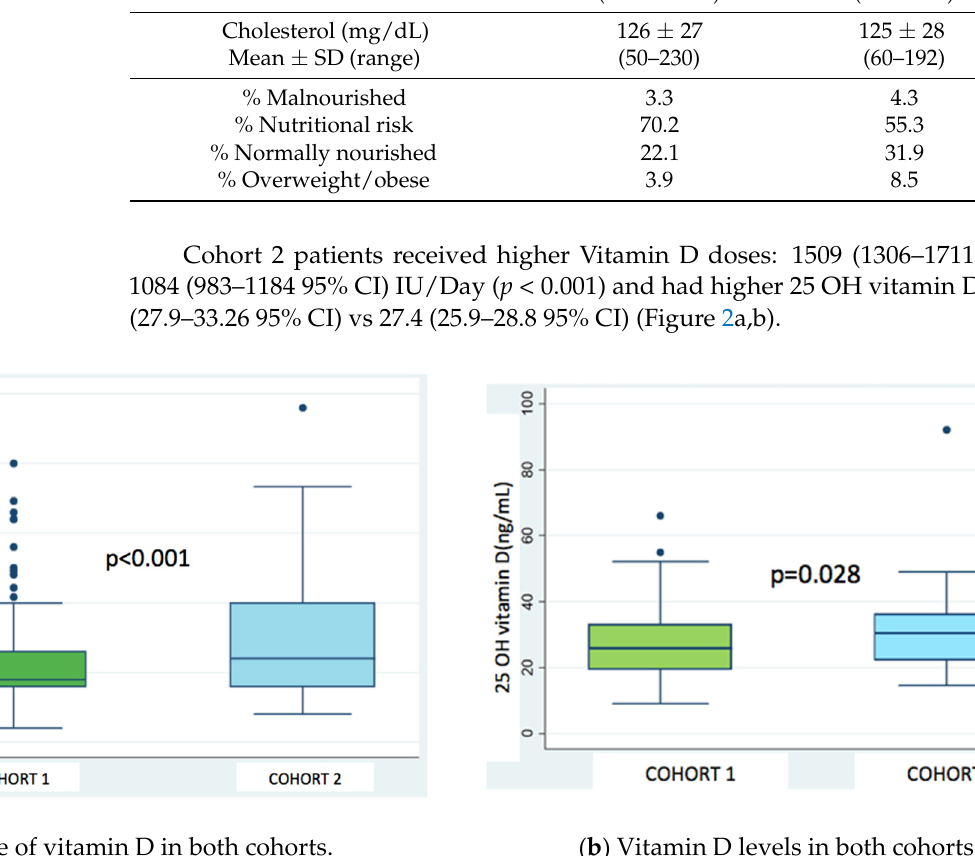
Figure 2. Dose ( a ) and levels ( b ) of vitamin D in both cohorts. A higher proportion of patients with insufficient vitamin D serum levels (<30 ng/mL) was observed in cohort 1: 65% vs 48% ( p = 0.011). The prevalence of patients with vitamin D deficiency (levels <20 ng/mL) was also higher in cohort 1, but these differences were not statistically significant: 25% vs 15% ( p = 0.1). Adjusting for confounding factors, such as diagnosis by neonatal screening, age, Pseudomonas aeruginosa airway colonization, and BMI, patients in cohort 1 had a higher risk of vitamin D insufficiency compared to those in cohort 2 (OR 2.23) (Table 4). Table 4. Results of multivariable linear regression for risk of vitamin D insuffiency (serum 25 OH vitamin D < 30ng/mL).